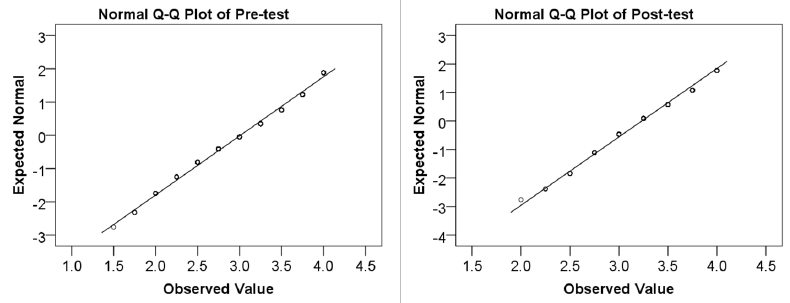
Fig. 3. Normal Q-Q plot of the pre- and post-test